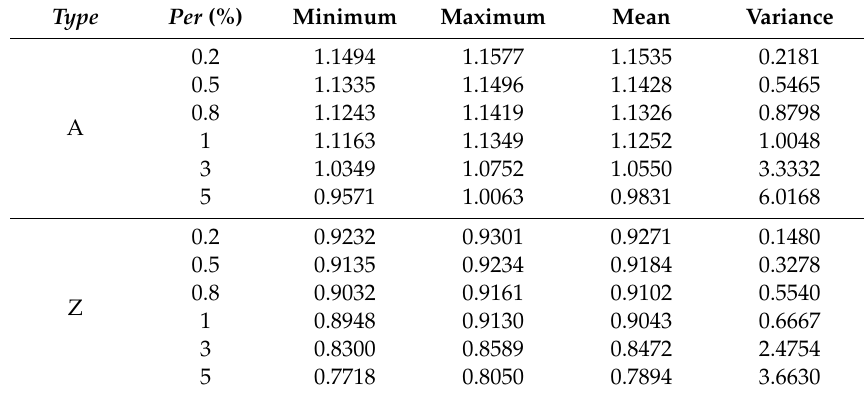
Table 2. Statistical thermal energy results for random distributed vacancy defects (unit: ×10 5 J).